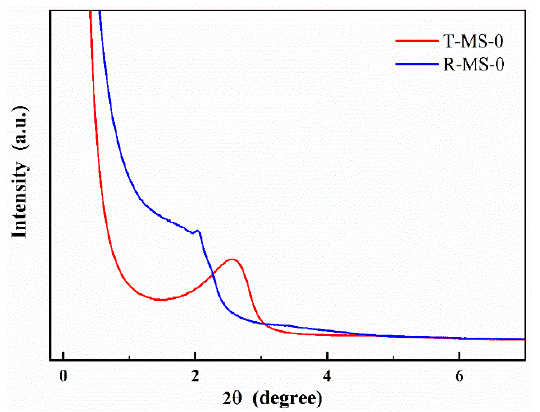
Figure 3. Low-angle XRD spectra of the T-MS-0 and R-MS-0.